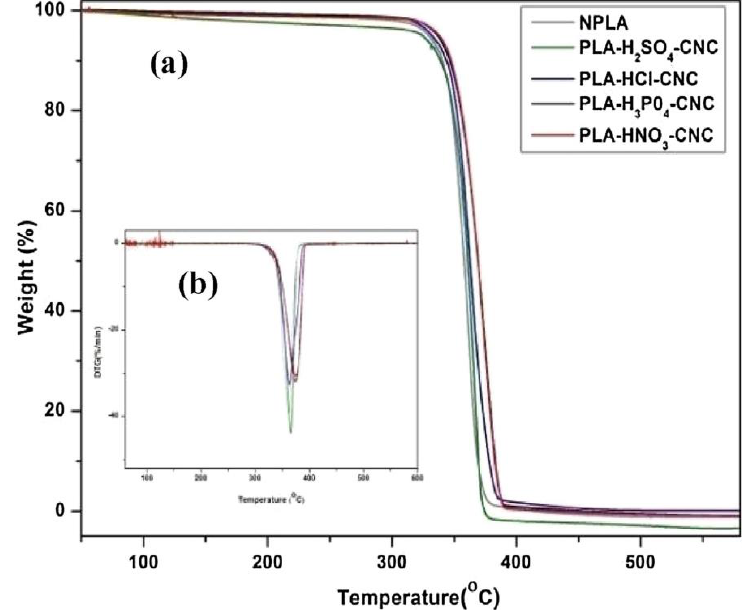
Figure 11. ( a ) Weight (%) versus temperature graph obtained from the TG data; and ( b ) DTG plots of PLA with different acid hydrolyzed CNC nanocomposite at β = 10 ◦ C/min. Reprinted by permission from [100].